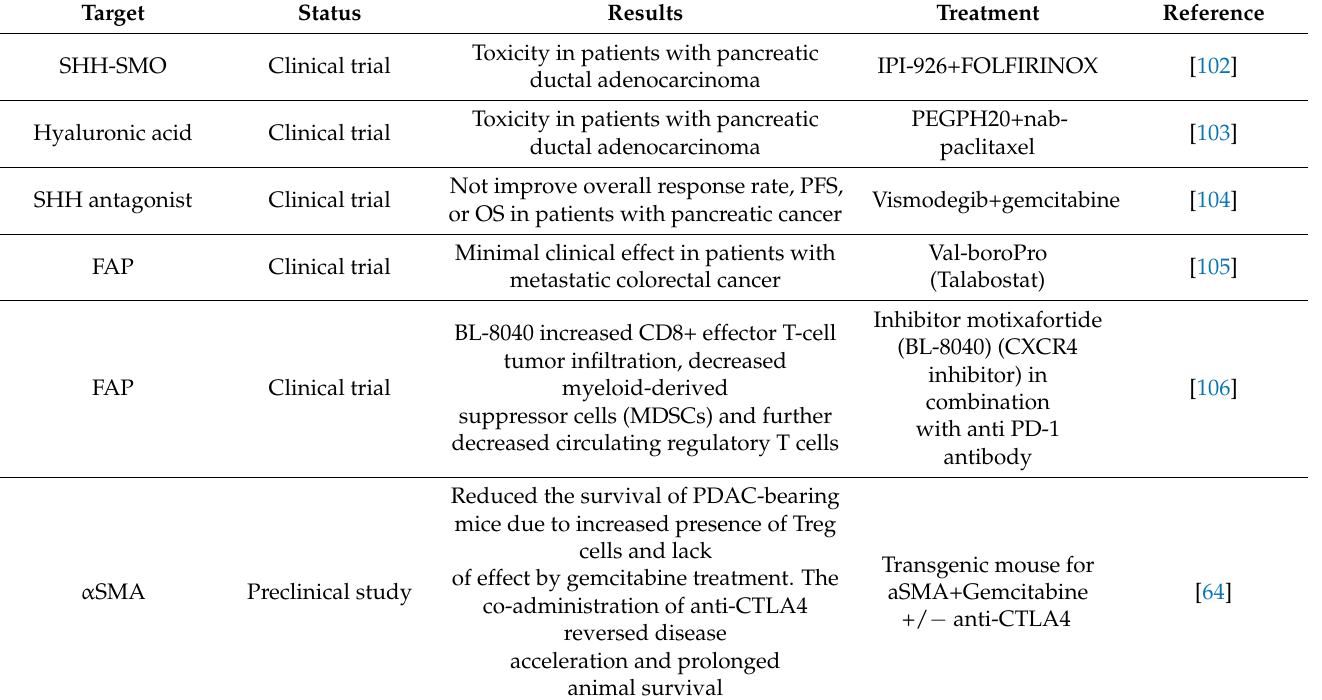
Table 1. Clinical trials and preclinical studies targeting